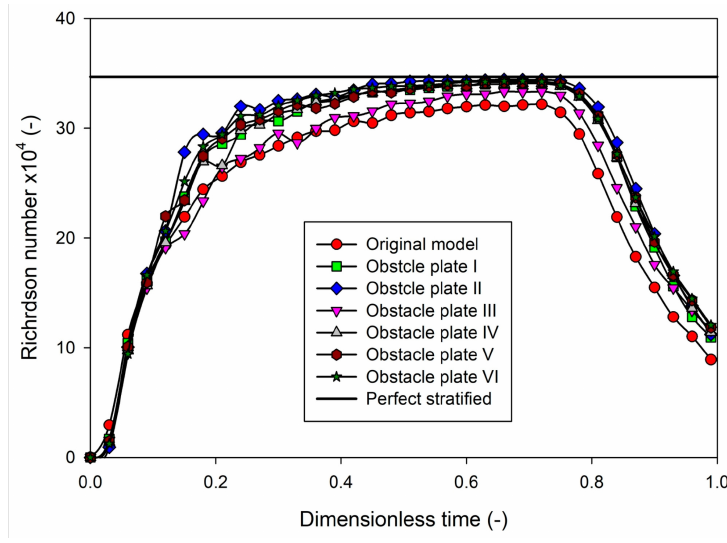
Figure 19. The Richardson numbers of the obstacle plate models.